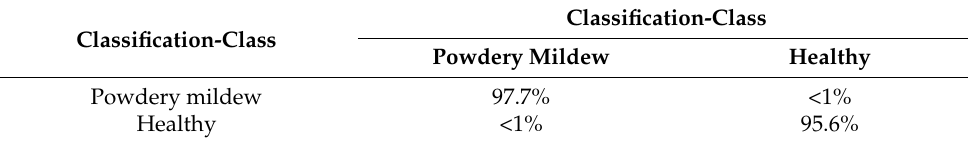
Table 3. Confusion matrix of powdery mildew vs. healthy mango